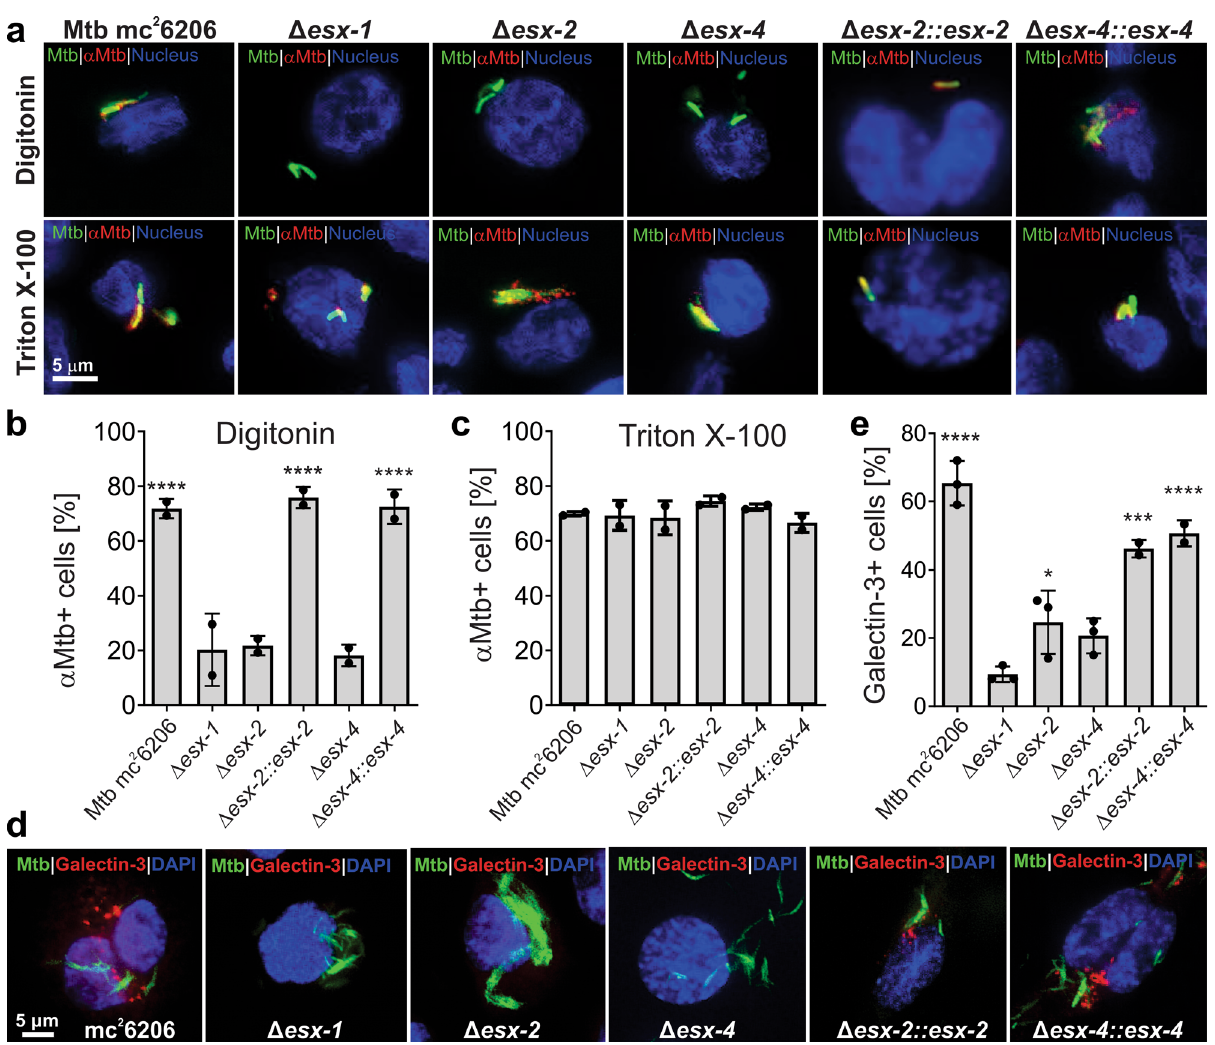
Fig. 5 The ESX-1, ESX-2, and ESX-4 systems are required for phagosomal rupture by M. tuberculosis . a Detection of phagosomal rupture in infected macrophages by using Mtb-speci fi c antibodies. The indicated Mtb strains were labeled with the metabolic dye DMN-Trehalose (green) and used to infect THP-1 macrophages at an MOI of 10:1. After 48 h of infection, the macrophages were permeabilized with digitonin to enable access of antibodies to the cytoplasm, or with Triton X-100 for access to intracellular compartments. Then, cells were stained with an anti-Mtb antibody ( α Mtb) and with an Alexa Fluor-594 secondary antibody (red). The macrophage nuclei were stained with DAPI. b , c Quanti fi cation of α Mtb-positive macrophages after permeabilization with digitonin ( b ) and Triton X-100 ( c ) from images shown in a . Macrophages were scored as α Mtb-positive when distinct red punctae were observed as compared to the Mtb esx-1 mutant treated with digitonin. d Detection of ruptured phagosomes in macrophages infected with Mtb. The indicated Mtb strains were labeled with the metabolic dye DMN-Trehalose (green) and used to infect THP-1 macrophages at an MOI of 10:1. After 48 h of infection, the macrophages were permeabilized with Triton X-100 and stained with an antibody against the phagosome rupture marker Galectin-3 and with an Alexa Fluor-594 secondary antibody (red). e . Quanti fi cation of Galectin-3-positive macrophages from images shown in d . Macrophages were scored as Galectin-3-positive when distinct red punctae were observed as compared to the Mtb esx-1 mutant. The Δ esx-1 strain has a deletion of the RD1 region and lacks the panCD genes. Data are represented as mean ± SEM of at least two independent experiments ( n ≥ 2) and representative images are shown. Asterisks indicate signi fi cant differences (* p value ≤ 0.05, ** p value ≤ 0.01, *** p value ≤ 0.001, **** p value ≤ 0.0001, calculated using the one-way ANOVA with Dunnett ’ s correction) compared with the Mtb Δ esx-1 strain. Source data are provided in the Source Data fi